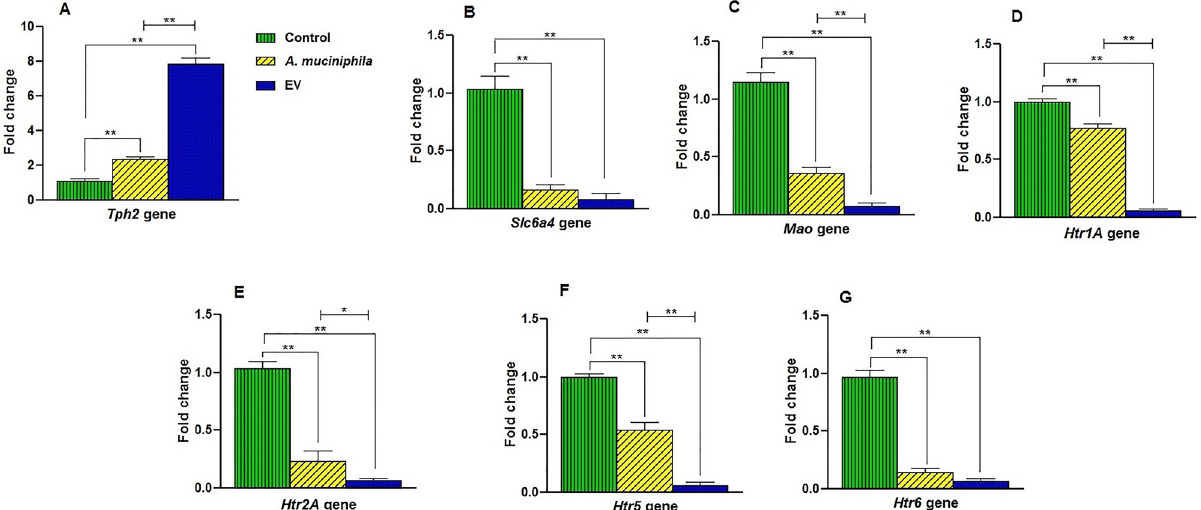
Figure 4. Administration of A. muciniphila and its EVs induced changes in the expression of hippocampal serotonergic system-related gene in mice. Expression of ( A ) Tph2 ( B ) Slc6a4 ( C ) Mao ( D ) Htr1A ( E ) Htr2A ( F ) Htr5 , and ( G ) Htr6 genes. Data are normalized using RPL13a and β-actin as control genes. *, **, ’P < 0.05 and P < 0. 01 were considered statistically significant,